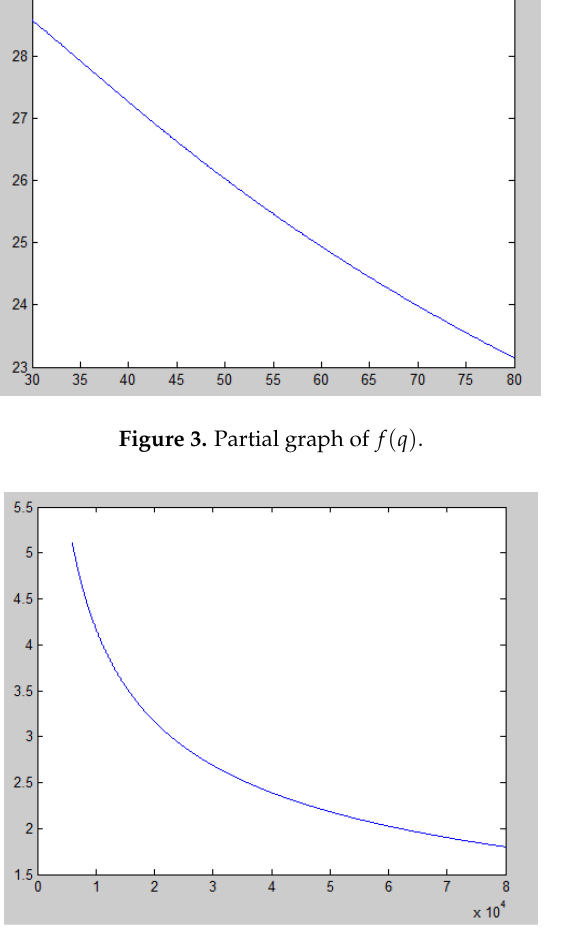
Figure 4. Partial graph of f ( q )